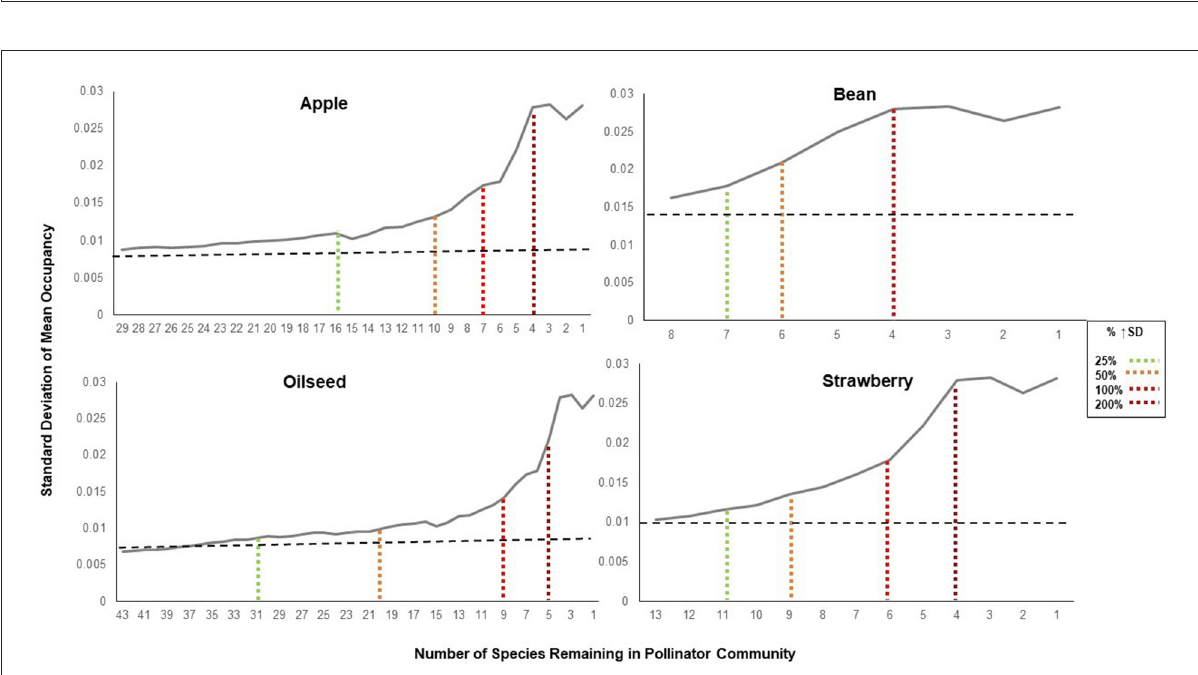
FIGURE4 Standard deviation of mean occupancy for bee crop pollinator communities as successive species are removed for apple, bean, oilseed and strawberry crops. Gray dashed line denotes standard deviation of mean occupancy for bee crop pollinator community if all species are